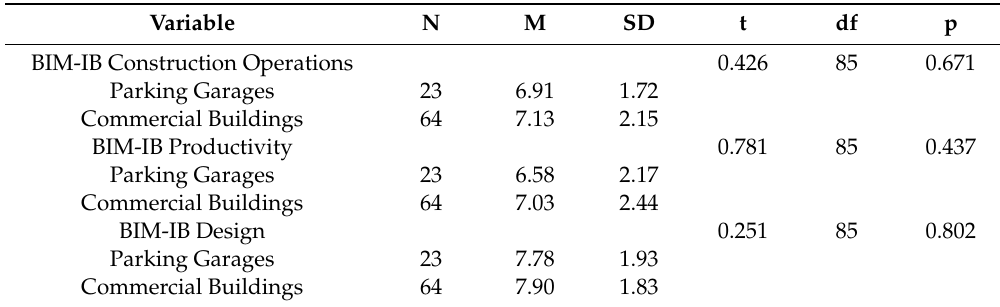
Table 5. Benefits of BIM Implementation: Construction Operations-, Productivity- and Design-Related Factors by Building Type (RQ2).